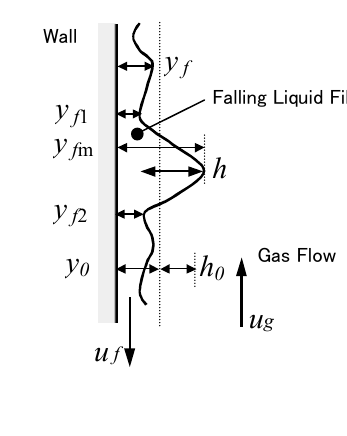
Fig.7 Wave in the counter-current flow